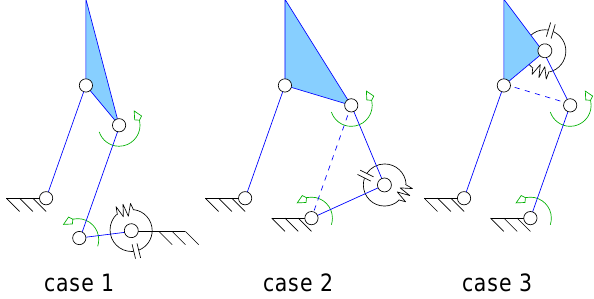
Figure 8. Designs of the two-phalanx class S architecture allowing pinch